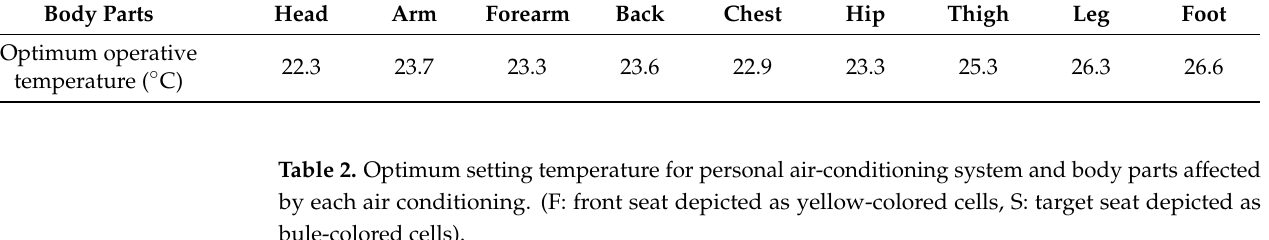
Figure 2. Inlets (red-colored) and outlets (blue-colored) for personal air-conditioning system; outlets are positioned in six different areas. Table 1. Ideal temperature distribution for each body part.